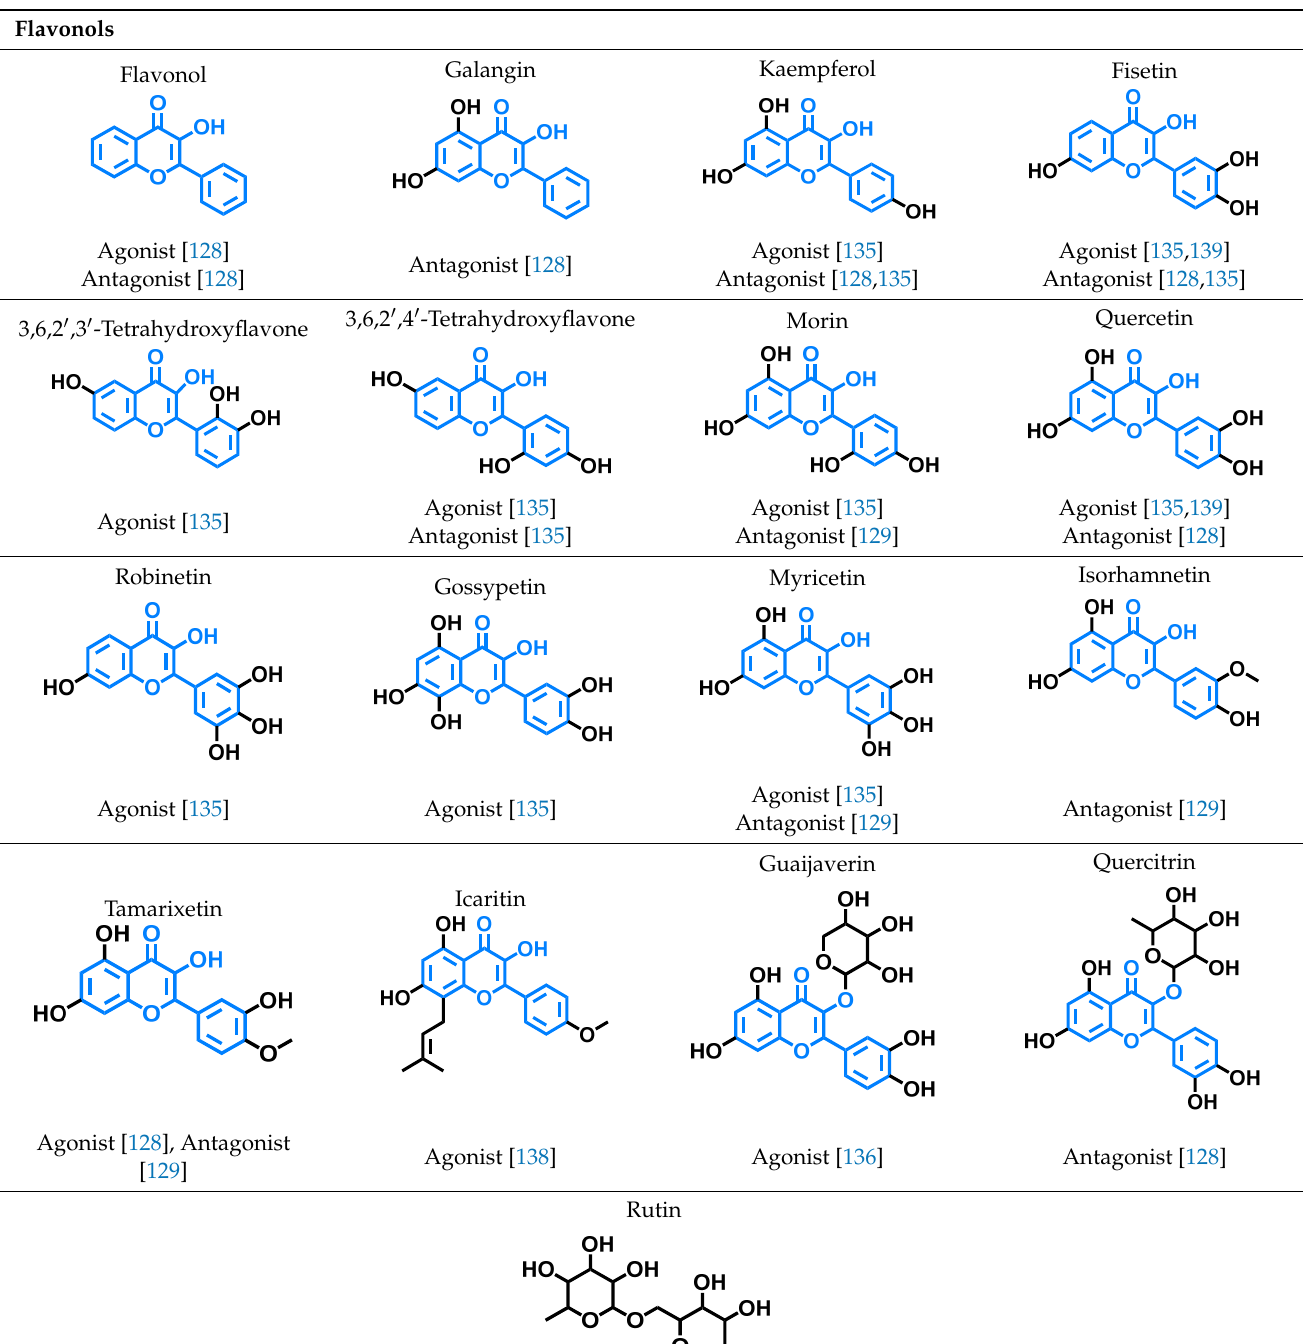
Table 3. Structures and AhR activity reported for the flavonol class of compounds.